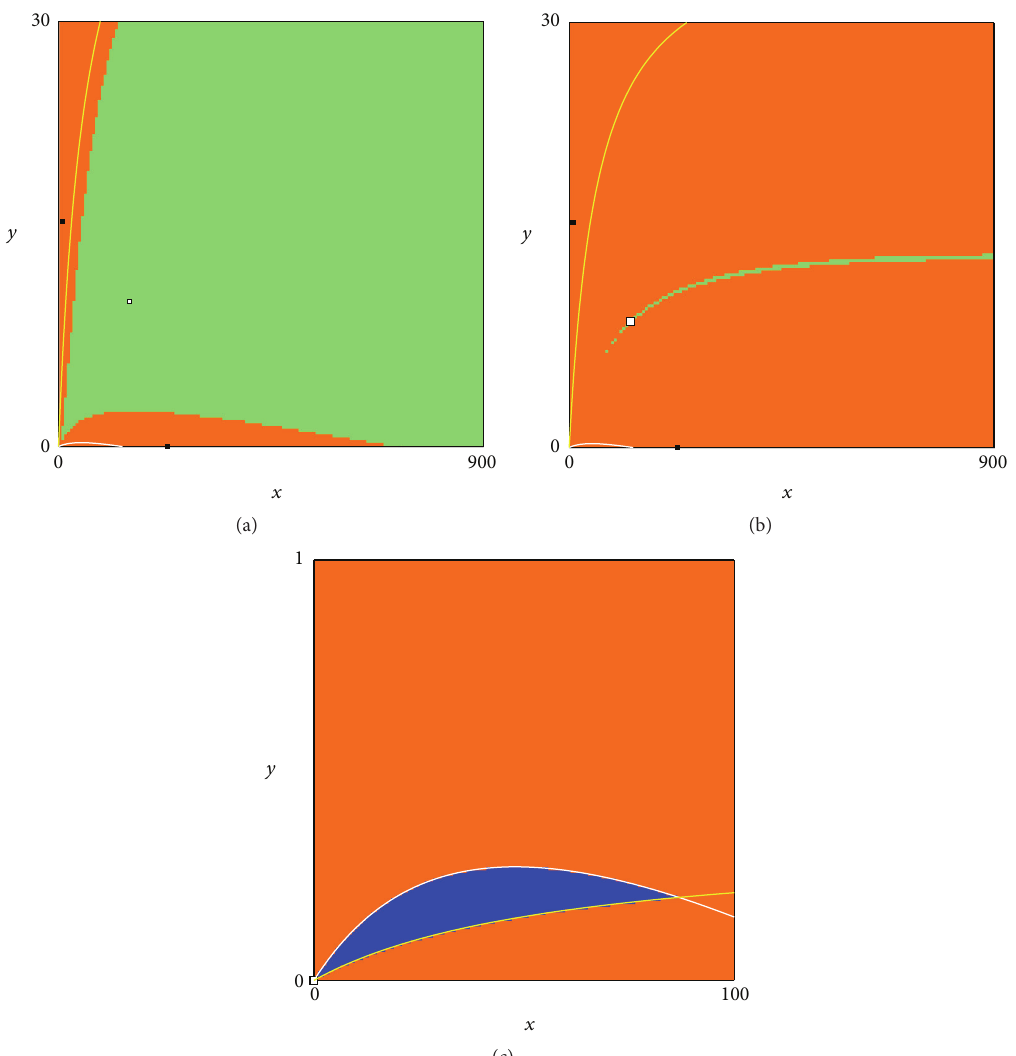
Figure 4: (a) 𝐹 = 0.5 . Before the flip bifurcation at 𝐹 ≃ 0.6441 , 𝑃 ∗ (white point) is locally stable and it coexists with a stable 2-period cycle (black points): their basins are depicted in green and orange, respectively. (b) 𝐹 = 0.64 . Immediately before the flip bifurcation the two coexisting attractors are depicted together with their own basins. (c) 𝐹 = 60 . A generic trajectory may converge to the extinction equilibrium 𝐶 𝑃 𝑃 0 or to 2 . The stable set of 0 is depicted in blue while the basin of attraction of